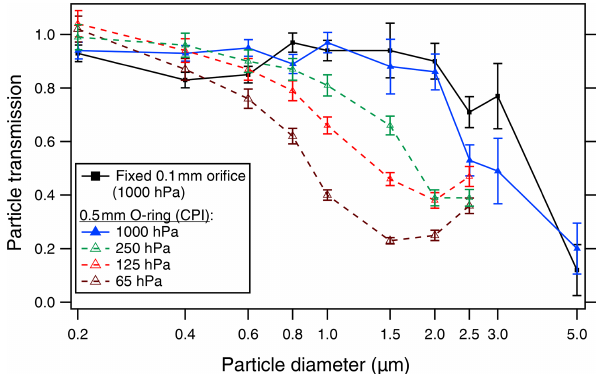
Figure 8. Transmission of PSL particles through the CPI device (blue line) and an aerodynamic lens in comparison to the same aero- dynamic lens with a fixed 0.1mm diameter critical orifice (black line). Filled data markers denote results at 1000hPa inlet pressure. Error bars include statistical particle-counting uncertainty, as well as uncertainties in the fitted function parameters and tube loss cor- rections. Open markers denote results for inlet pressures of 250, 125, and 65hPa. Measurements were also performed for 380hPa but are not included here for clarity.